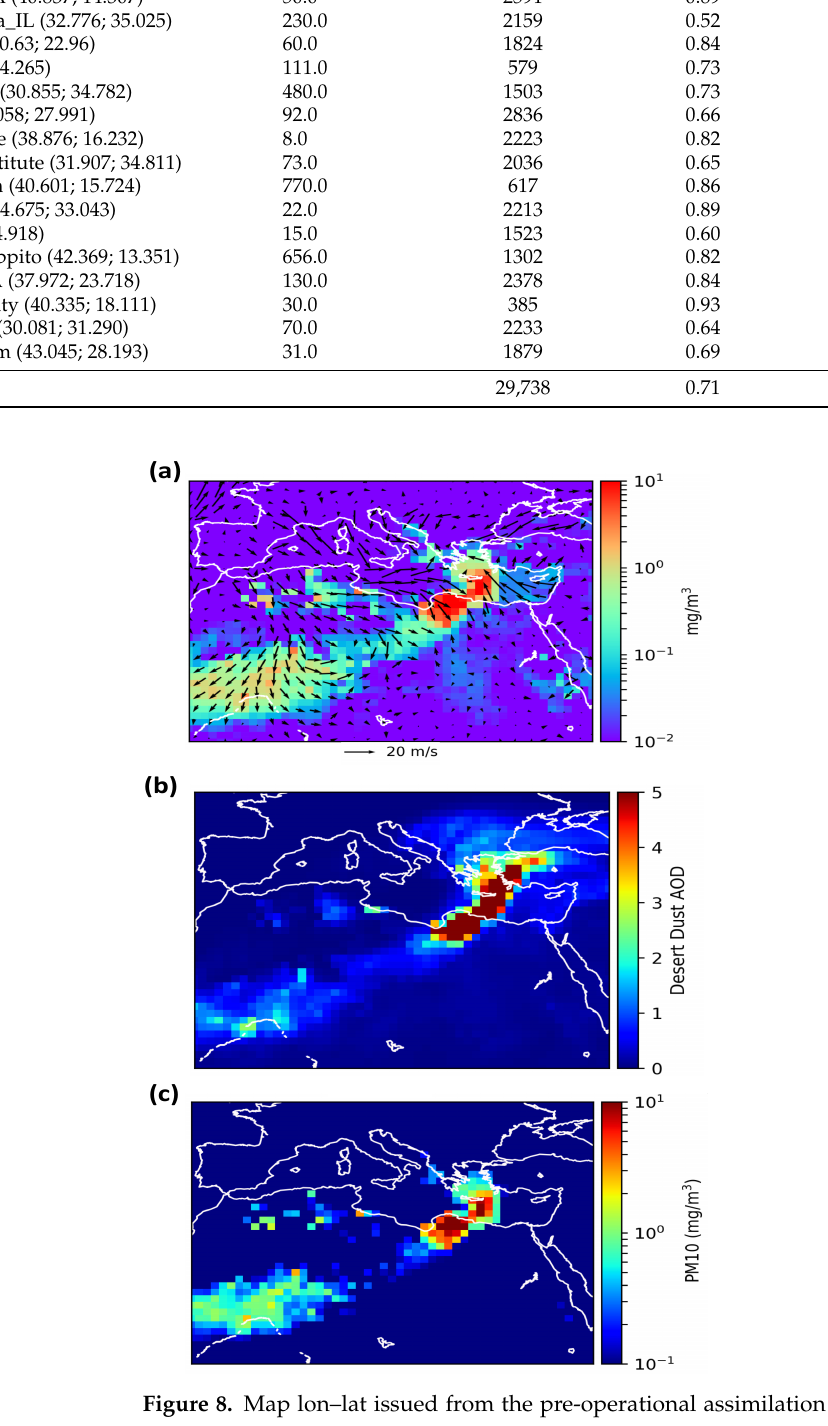
Figure 8. Map lon–lat issued from the pre-operational assimilation system for the day 22 March 2018 at 12:00 for different aerosol products: ( a ) Surface desert dust concentration in mg · m − 3 super- imposed by the wind direction and intensity presented by the black arrows; ( b ) the desert dust aerosol optical depth; ( c ) the surface PM10 concentration in mg · m − 3